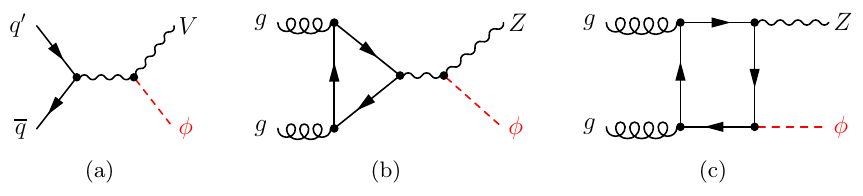
Figure 1 . Leading-order Feynman diagrams to (cid:27) V(cid:30) , see eq. (2.1): (a) DY -like terms (cid:27) V(cid:30) (b,c) gluon-initiated contribution (cid:27) gg ! Z(cid:30)